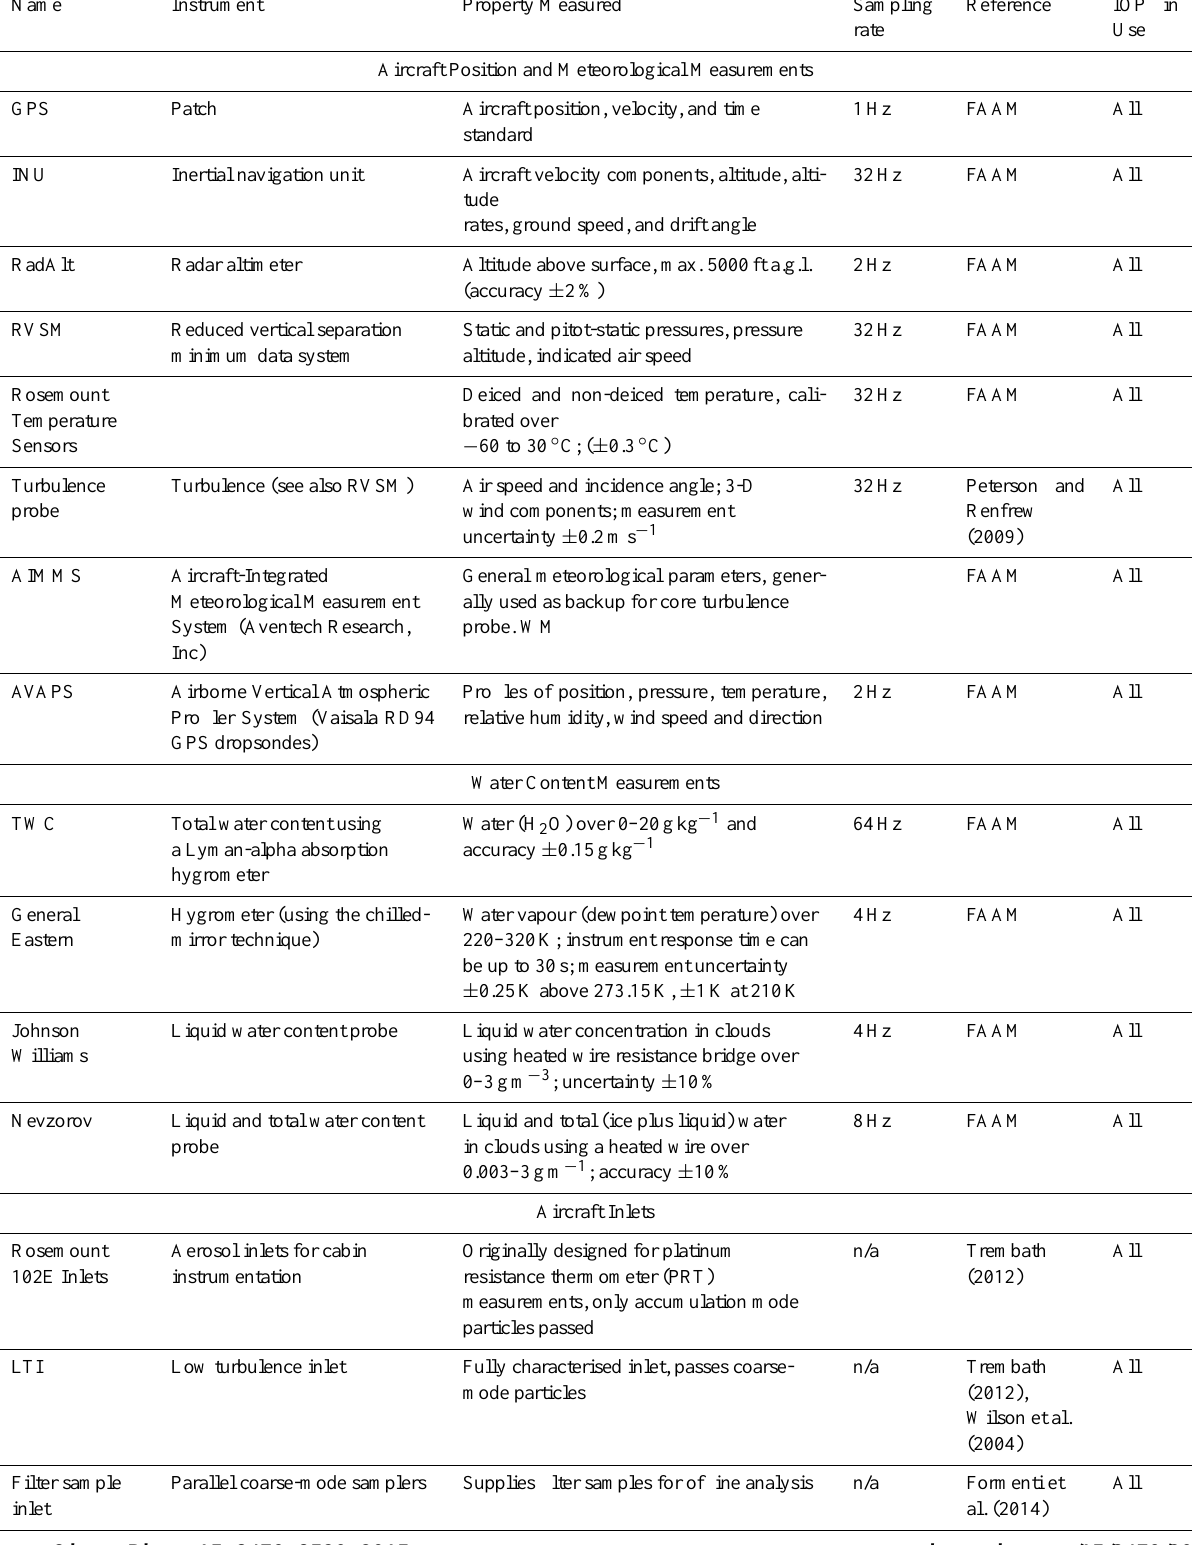
Table 4. Instrumentation on the BAe146 aircraft relevant to Fennec. WM is wing mounted, CAB is inside aircraft cabin, PNC is particle number concentration, OPT is optical scattering measurements, SH is light shadowing measurements. Size ranges shown for optical instru- ments refer to nominal ranges provided by manufacturers, i.e. not corrected for aerosol type-specific refractive indices. FAAM refers to the FAAM website where full instrumentation details are provided at